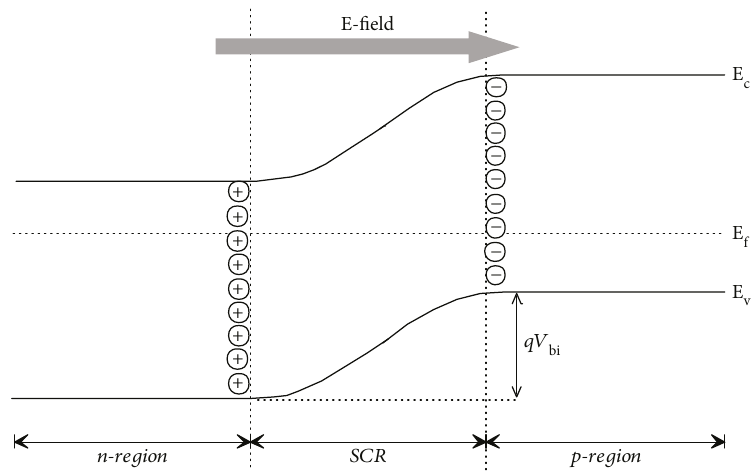
Figure 1: Energy band diagram of a p - n junction at thermal